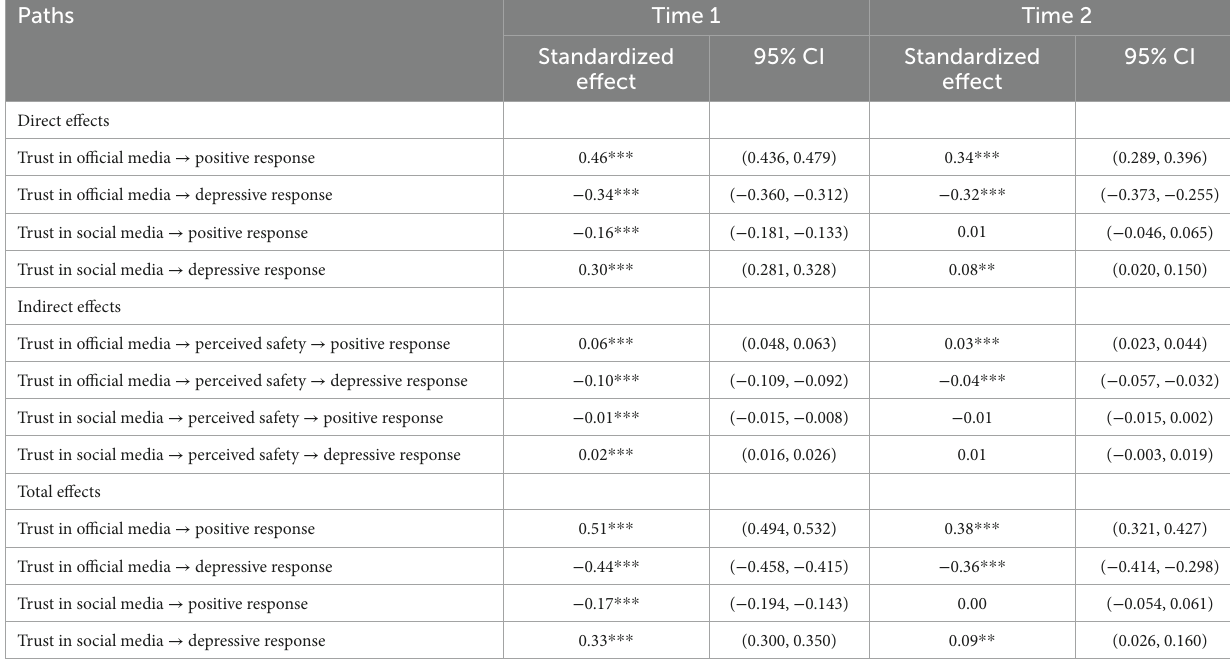
TABLE 5 The direct, indirect, and total effects of trust in media sources on public’s wellbeing at Time 1 and Time 2.